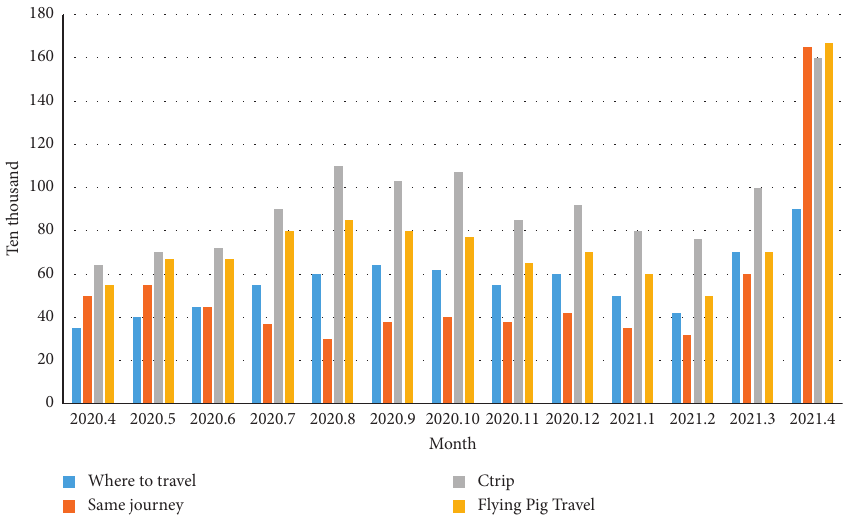
Figure 8: Travel platform access information for travel reservation.